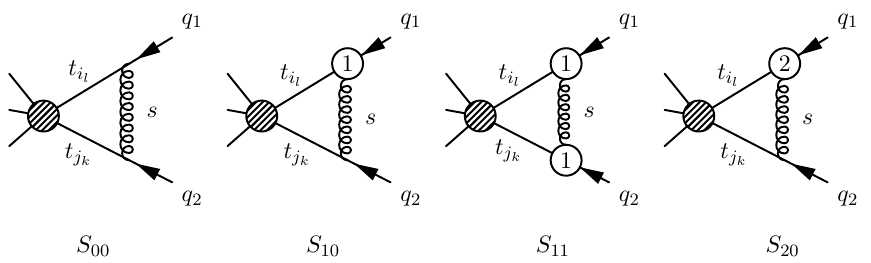
Figure 1 . Sample diagrams for a soft gluon connecting two fermionic building blocks in collinear direction i and j , respectively. The numbered vertices indicate insertions of vertices derived from ( n ) with n = 1 ; the subleading power SCET Lagrangian L